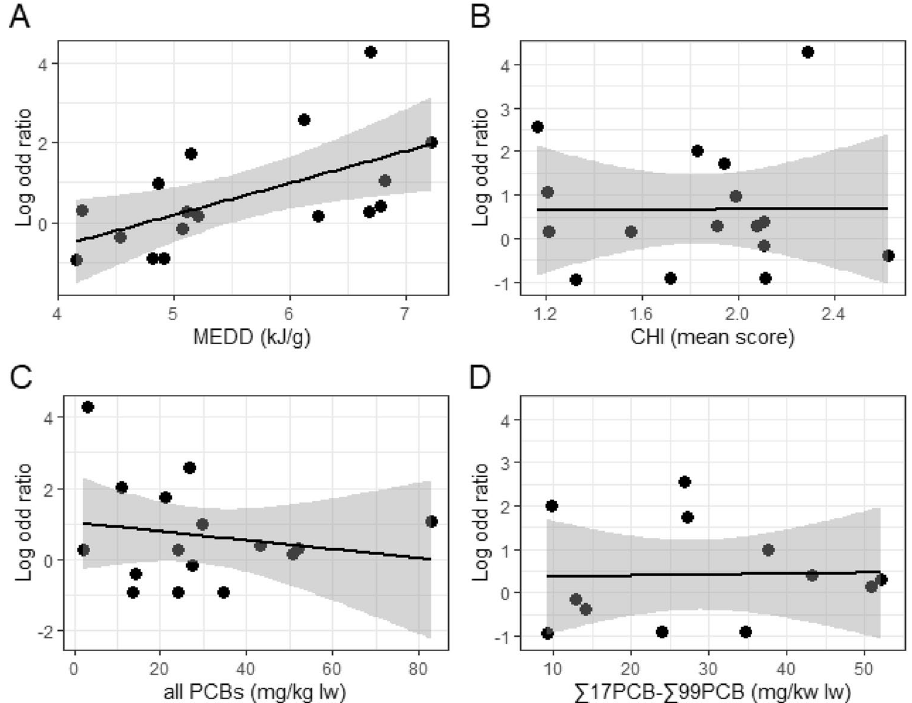
Figure 2. Log odds ratios (y-axis) of being pregnant (versus being non-pregnant) in relation to the environmental conditions (x-axis): (A) the mean energy density of the diet (MEDD) (STab. 5), (B) cumulative human impact (CHI) mean scores (STab. 10), (C) chemical pollution by PCBs (PCB1) and (D) chemical pollution by PCBs restricted to studies reporting ≥ ∑17PCB− ≤ ∑99PCB (PCB2) (STab. 11 and 12). A linear regression line is fitted to all graphs, with the grey shaded areas reflecting 95%